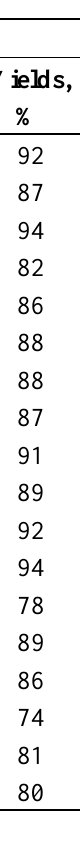
Table 1 . Syntheses of azaheterocyle salts under MW and classical heating conditions, in liquid